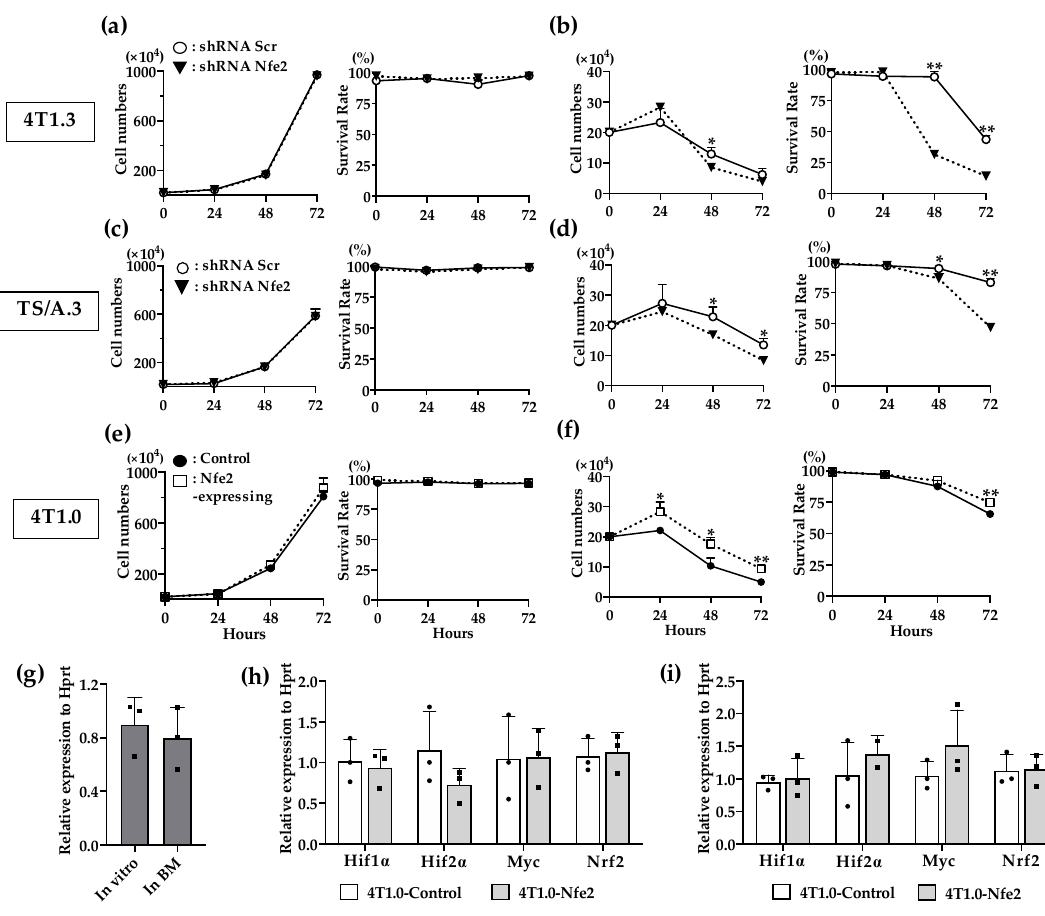
Figure 5. ( a , b ) In vitro proliferation rates of Nfe2 shRNA- or scrambled shRNA-transfected 4T1.3 cells under normoxic ( a ) or hypoxic and anchorage-independent conditions ( b ). ( c , d ) In vitro proliferation rates of Nfe2 shRNA- or scrambled shRNA-transfected TS / A.3 cells under normoxic ( c ) or hypoxic and anchorage-independent conditions ( d ). ( e , f ) In vitro proliferation rates of Nfe2 -expressing or control vector-transfected 4T1.0 cells under normoxic ( e ) or hypoxic and anchorage-independent conditions ( f ). Each of the cell lines were cultured under normoxic (20% O 2 ) or hypoxic (1% O 2 ) and anchorage-independent conditions, respectively. Cell numbers and survival rates under each condition were determined by using trypan blue exclusion assay. All values represent mean + SD ( n = 3). * p < 0.05, ** p < 0.01. ( g ) Expression level of Hif1 α mRNA expression in 4T1.3 cells, which were cultured in vitro, or grew in a bone cavity. Total RNAs were extracted from 4T1.3 cells, which were cultured in vitro (In vitro) or grew in a bone cavity (In BM) at day 7 after intraosseous injection. All values represent mean + SD ( n = 3). ( h , i ) Determination of mRNA expression level of hypoxia-related genes in Nfe2 -expressing or control vector-transfected 4T1.0 cells, which was cultured under normoxic or hypoxic and anchorage-independent conditions. Total RNAs were extracted from Nfe2 -expressing or control vector-transfected 4T1.0 cells cultured under normoxic ( h ) or hypoxic and anchorage-independent conditions ( i ), respectively. All values represent mean + SD ( n =